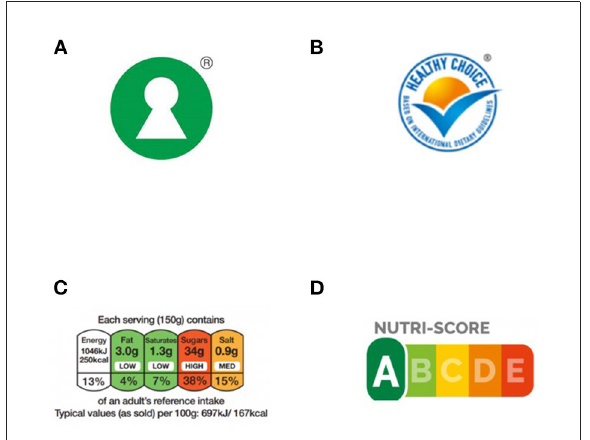
FIGURE1 The four main FOP labels currently in use in Europe: Keyhole (A) , choices (B) , multiple traffic light (C) , and Nutri-Score (D) .